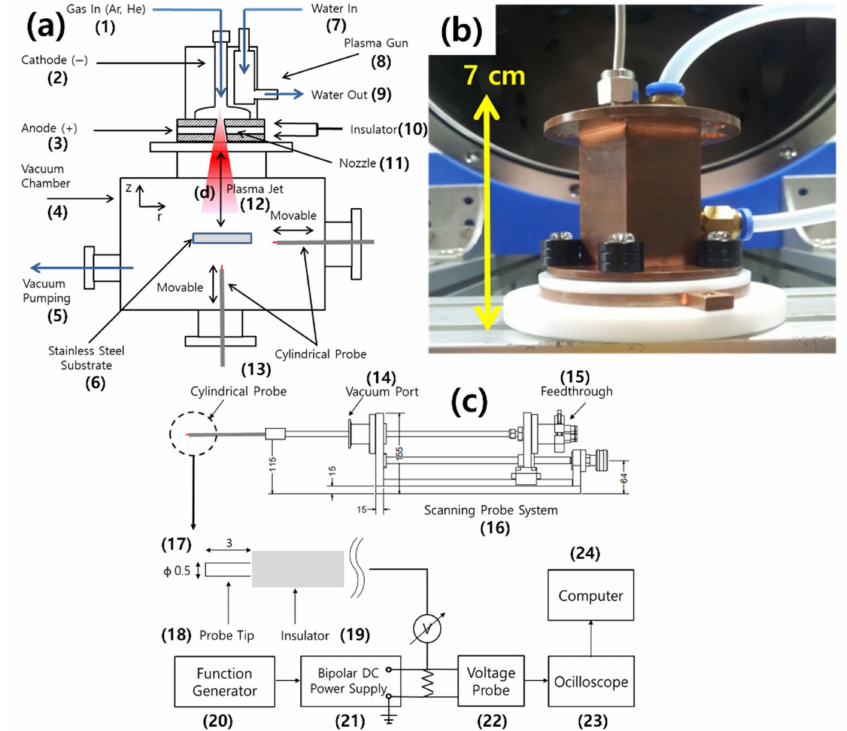
Figure 3. ( a ) Schematic view of a source system, ( b ) photograph of the developed source and ( c ) scan- ning probe system with the electric probe for measurement of plasma parameters. The distance ( d ) is 3 cm between the nozzle and substrate. (1) Gas in, (2) cathode, (3) anode, (4) vacuum chamber, (5) vac- uum pumping, (6) stainless steel substrate, (7) water in, (8) plasma gun, (9) water out, (10) insulator, (11) nozzle, (12) plasma jet, (13) cylindrical probe, (14) vacuum port, (15) feedthrough, (16) scanning probe system, (17) 0.5 × 3 mm (dia. × length), (18) probe tip, (19) insulator, (20) function generator, (21) bipolar DC power supply, (22) voltage probe, (23) oscilloscope and (24)